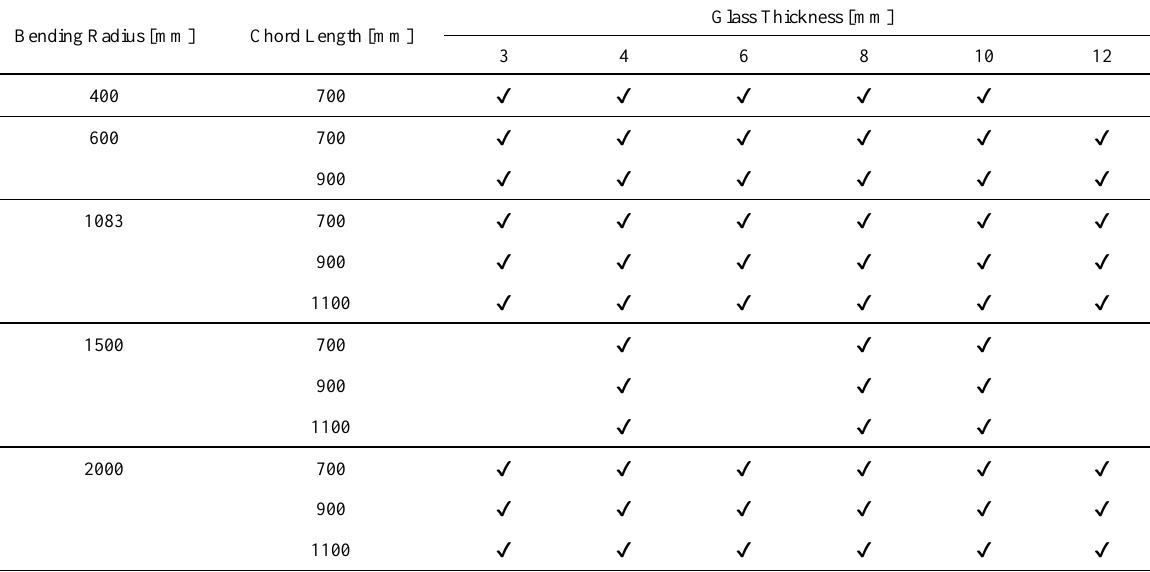
Table 1: Parameter array used in the investigations for the research project PRÜFgbGLAS